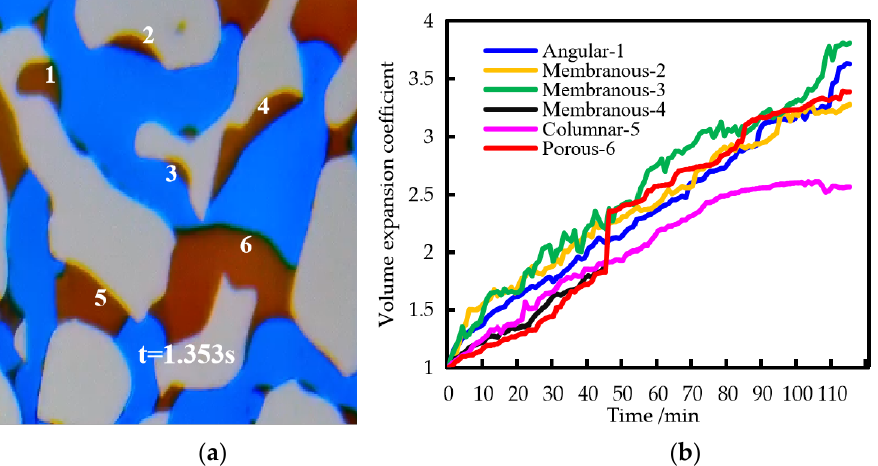
Figure 10. Variation of volume expansion coefficient of crude oil : ( a ) Variation states of remaining oil ; ( b ) Volume expansion coefficient of different crude oil .